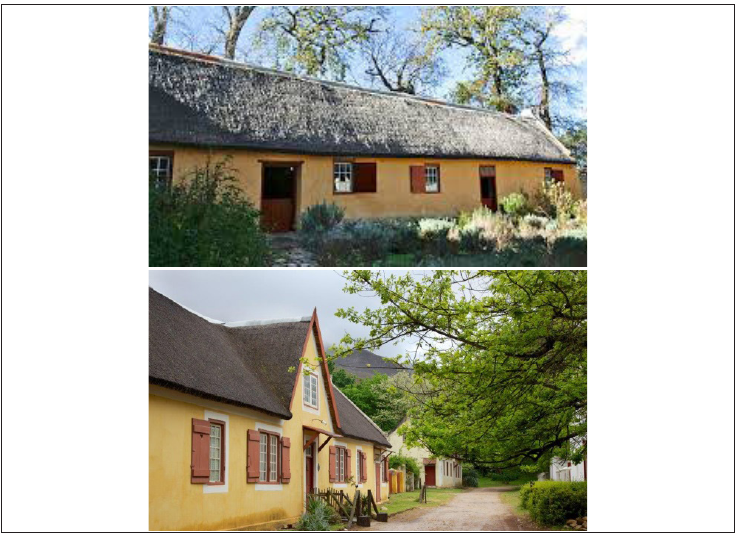
Figure 6: Photos of earth-construction private building around Church Square in